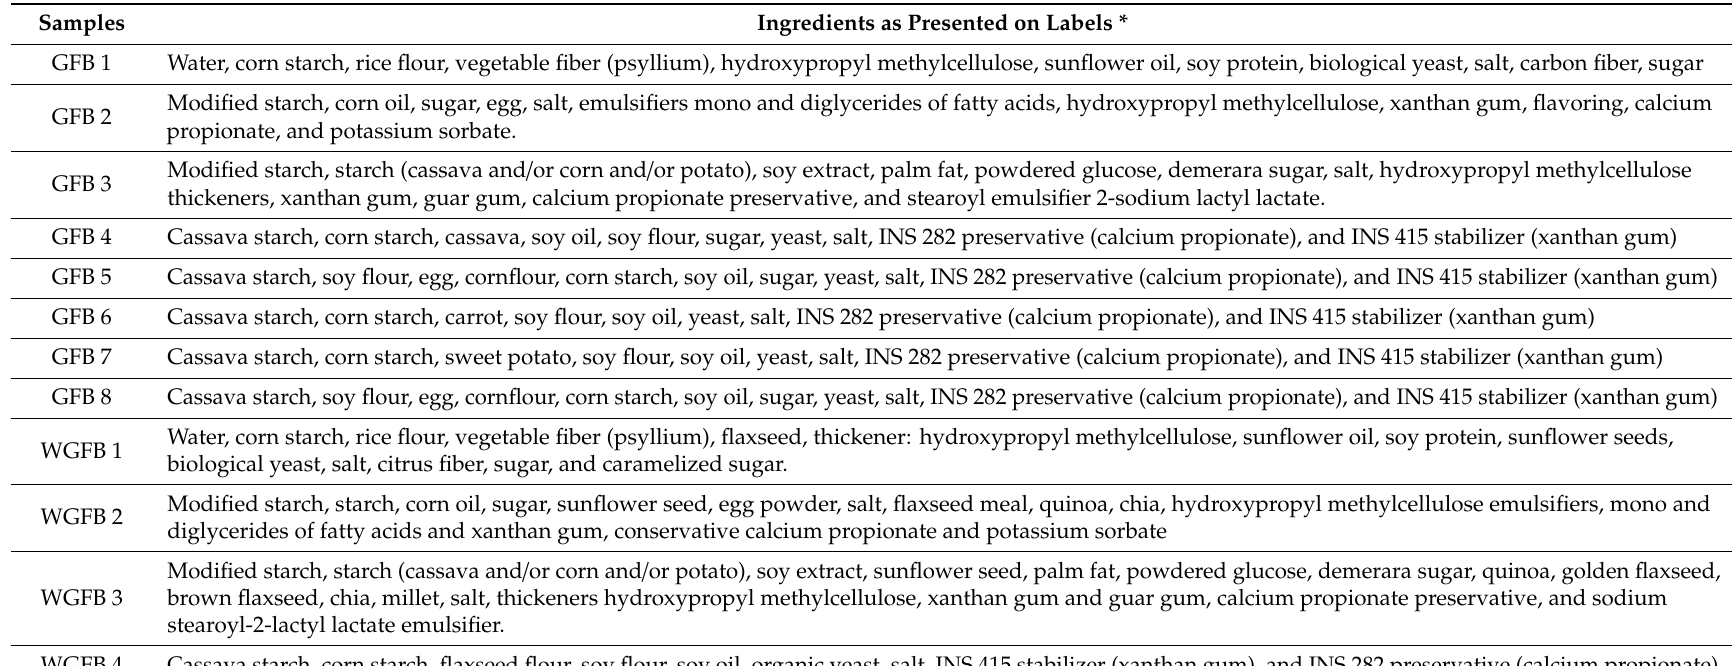
Table 1. Ingredients described on the labels of commercial gluten-free bread.